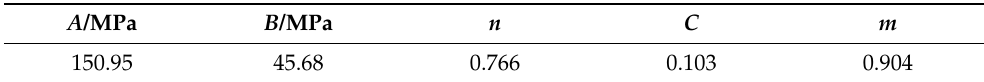
Table 2. Parameters for the Johnson–Cook model.